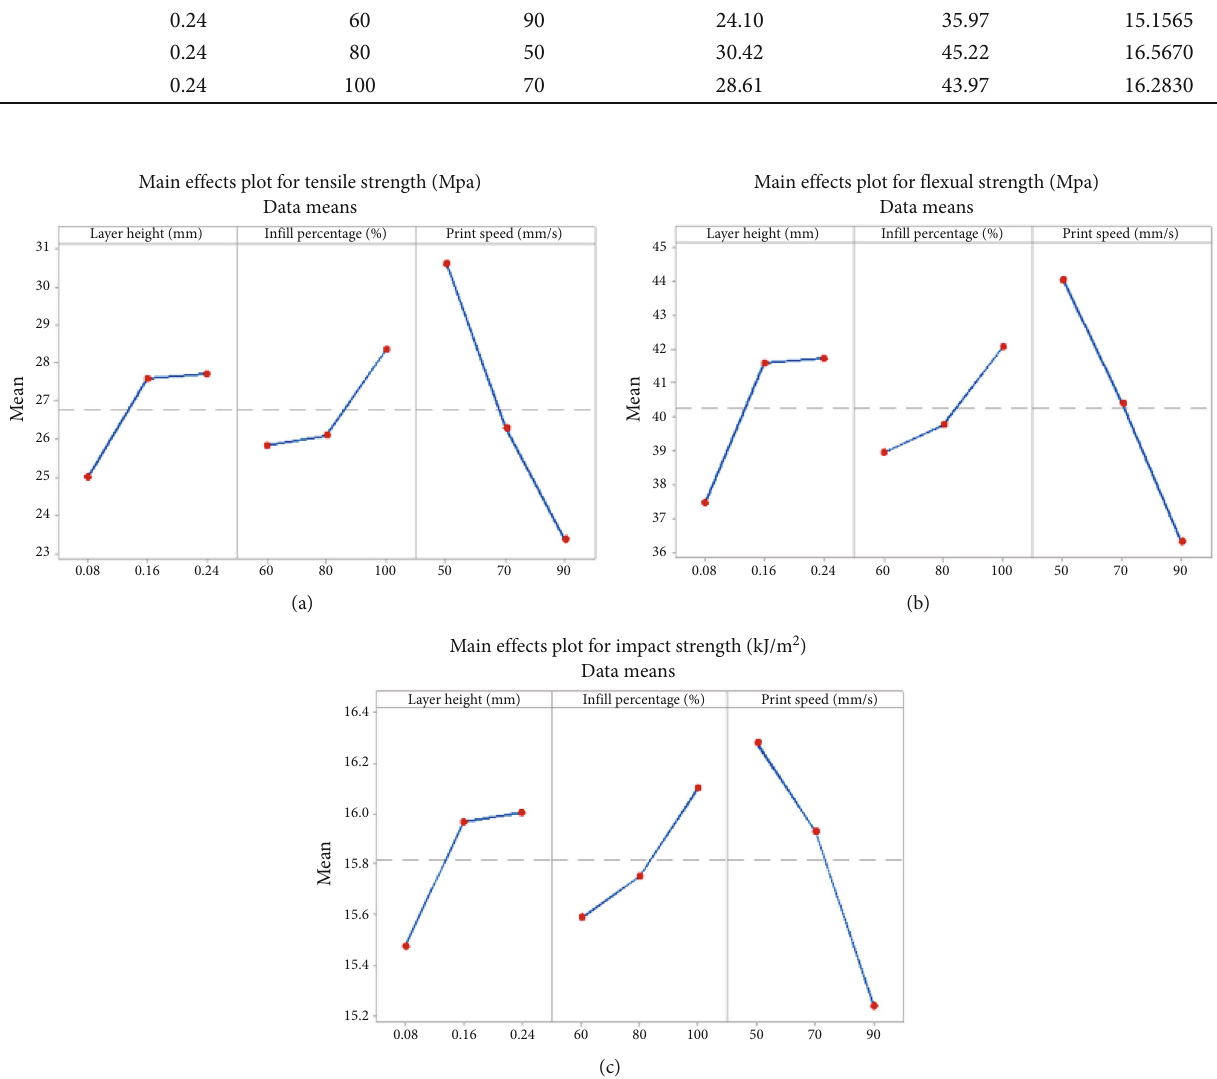
Figure 3: Main e ff ect plot for (a) tensile strength, (b) fl exural strength, and (c) impact